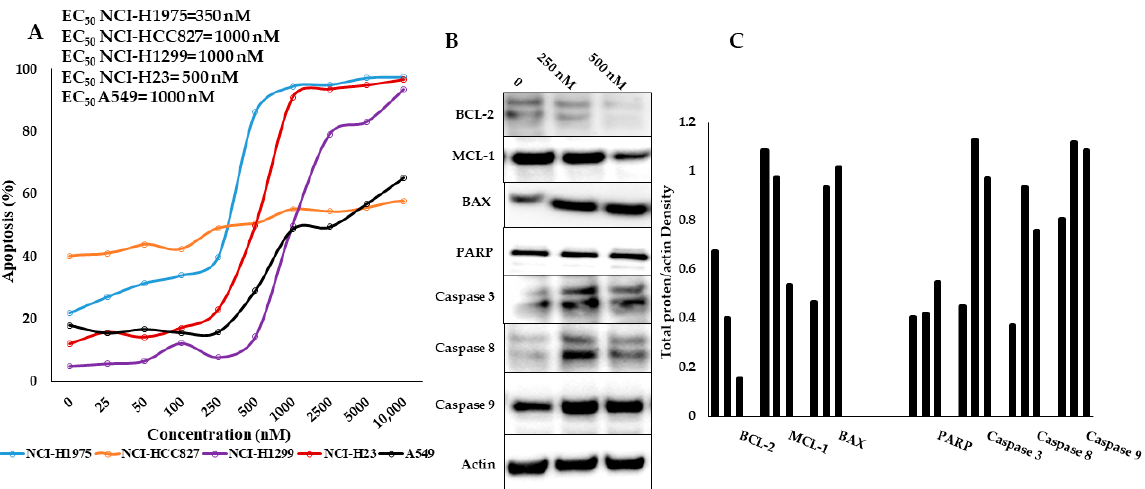
Figure 3. ( A ) Apoptosis ( A nnexin V/PI) of KAN0441571C in 5 lung cancer cell lines (EC 50 values are